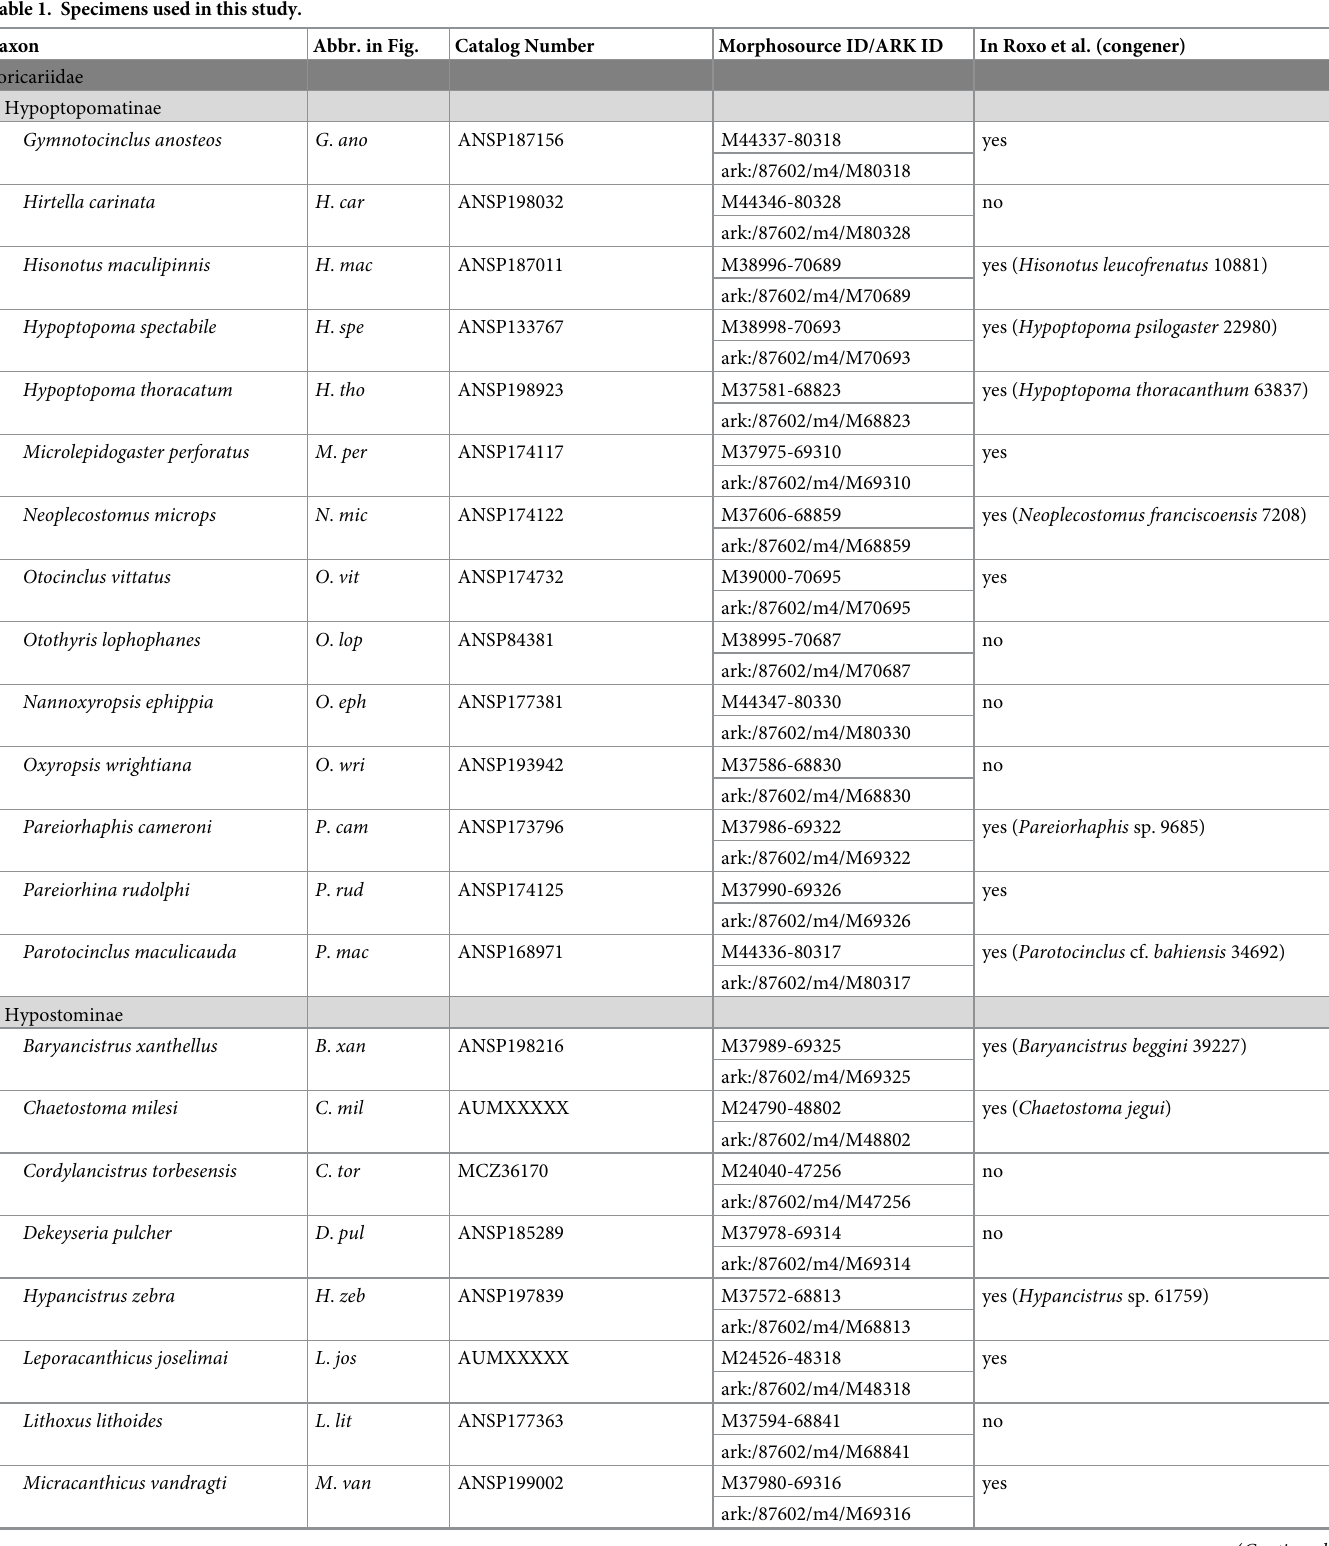
Table 1. Specimens used in this study.